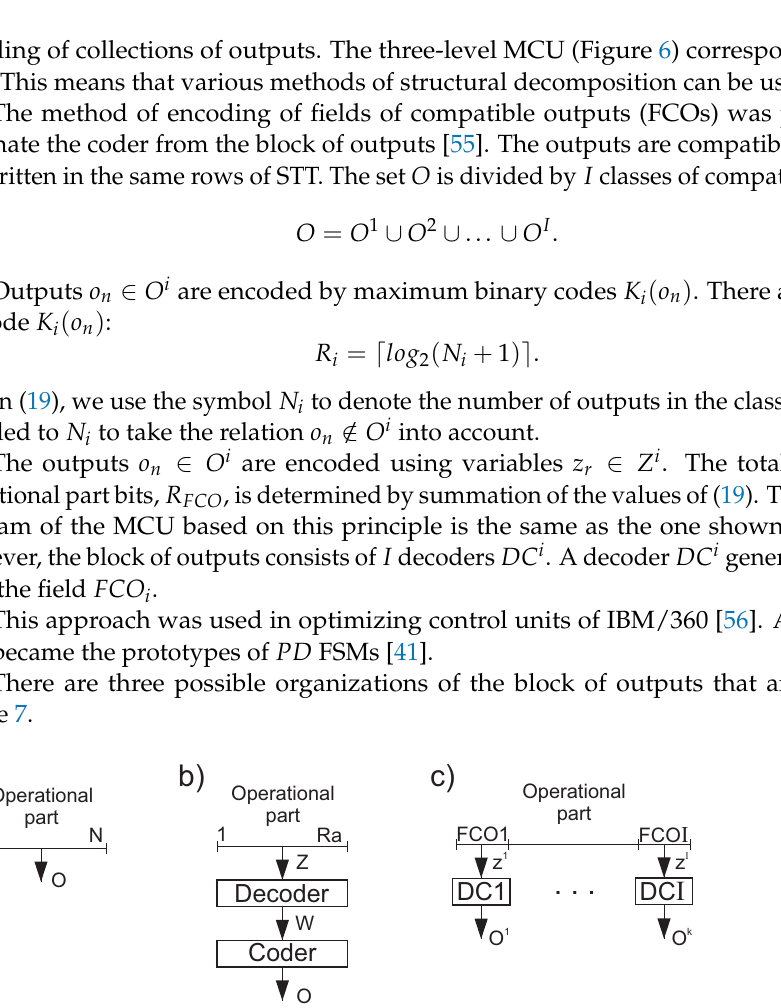
Figure 7. Organization of block of outputs with one-hot ( a ), maximum encoding ( b ) and encoding of FCO ( c